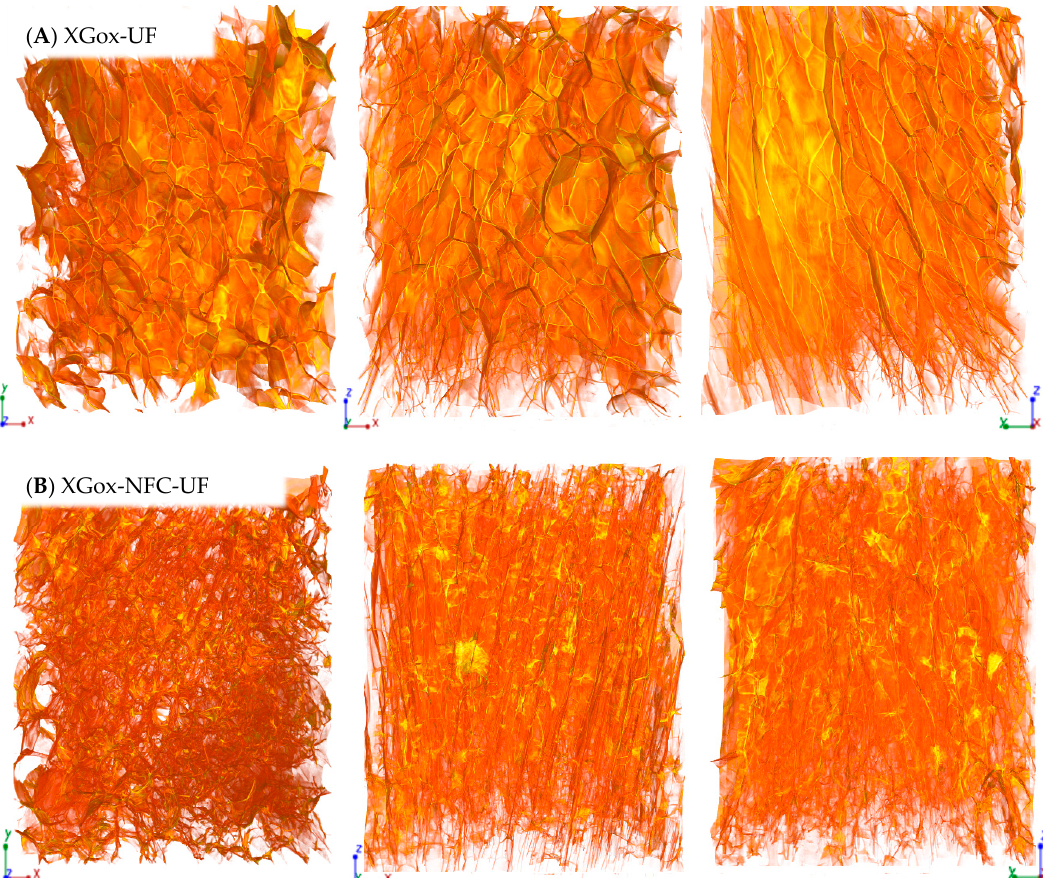
Figure 5. Three-dimensional reconstructed images from synchrotron phase contrast microtomography of ( A ) oxidized XG (XGox) aerogel and ( B ) aerogel reinforced with 25% NFC (XGox-NFC), prepared by unidirectional freezing (UF) using liquid nitrogen. The size is 495.33 × 495.33 × 660.33 µ m 3 in XYZ-axis.